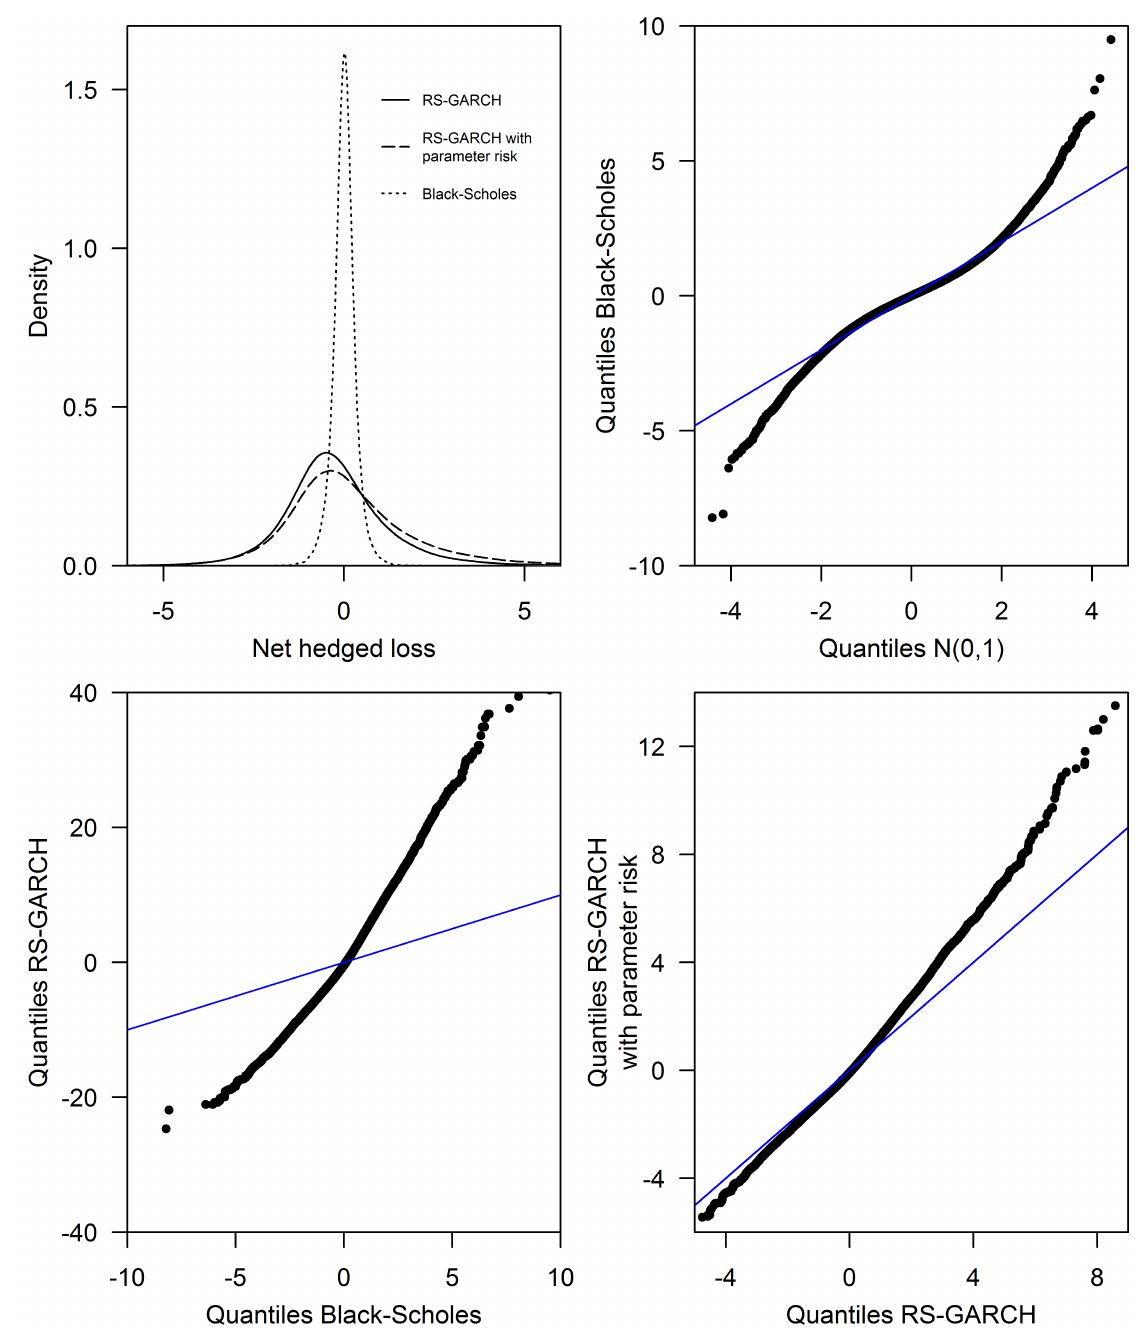
Figure 5. ( Top-left panel ): Empirical density of the net hedged loss ( X − Y ) based on 100,000 daily Y ) based on 100,000 Figure 5 – Top-left panel: Empirical density of the net hedged loss ( X scenarios projected under the Black–Scholes model, the RS-GARCH model and the RS-GARCH model − daily scenarios projected under the Black-Scholes model, the RS-GARCH model and the RS- with parameter risk. ( Other panels ): Q-Q plots of standardized quantiles comparing distributions GARCH model with parameter risk. Other panels: Q-Q plots of standardized quantiles comparing for the net hedged distributions for the net hedged loss.